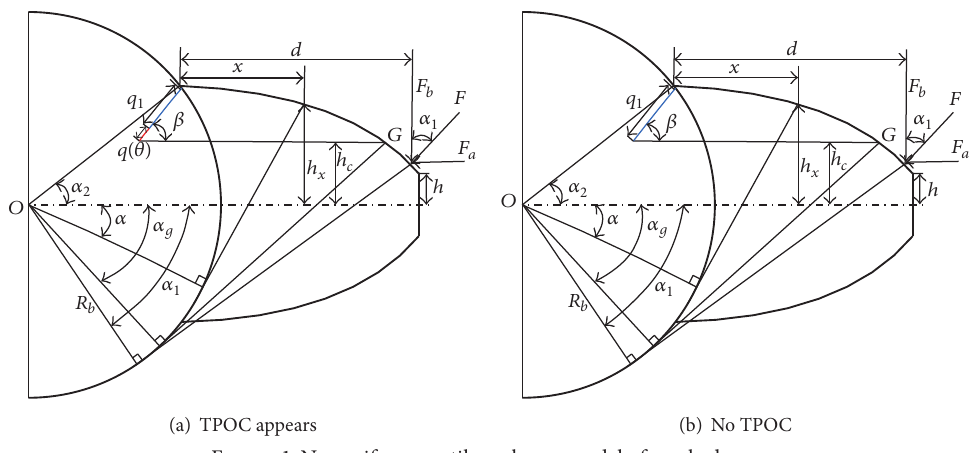
Figure 1: Nonuniform cantilever beam model of cracked